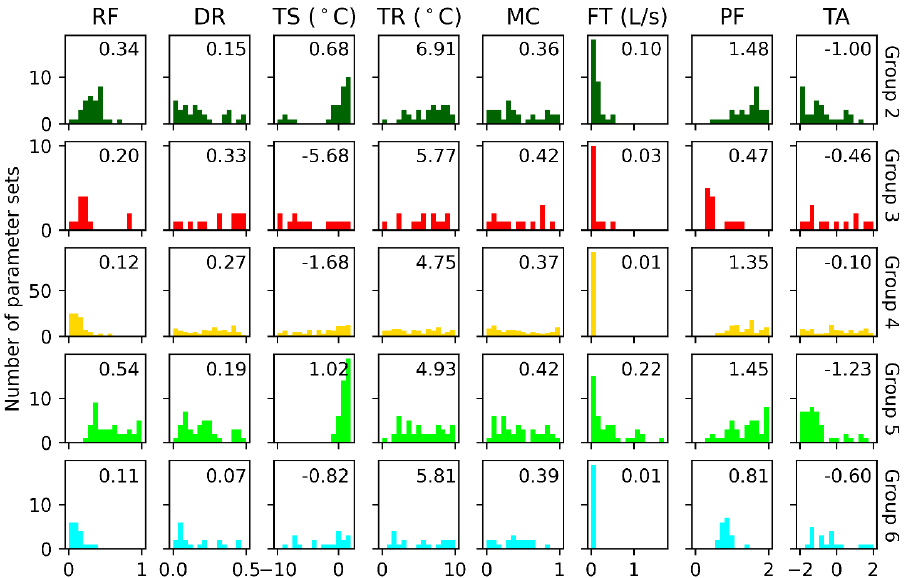
Figure 8. Distributions of suitable parameter values for parameter sets that met benchmark con- straints. The x-axis represents the sampled range of parameter values (Table 1), except for FT which is subset to 0.0–2.0 L/s to represent the full range of suitable values determined during calibration. Median values are displayed in the top-right corner of each histogram.